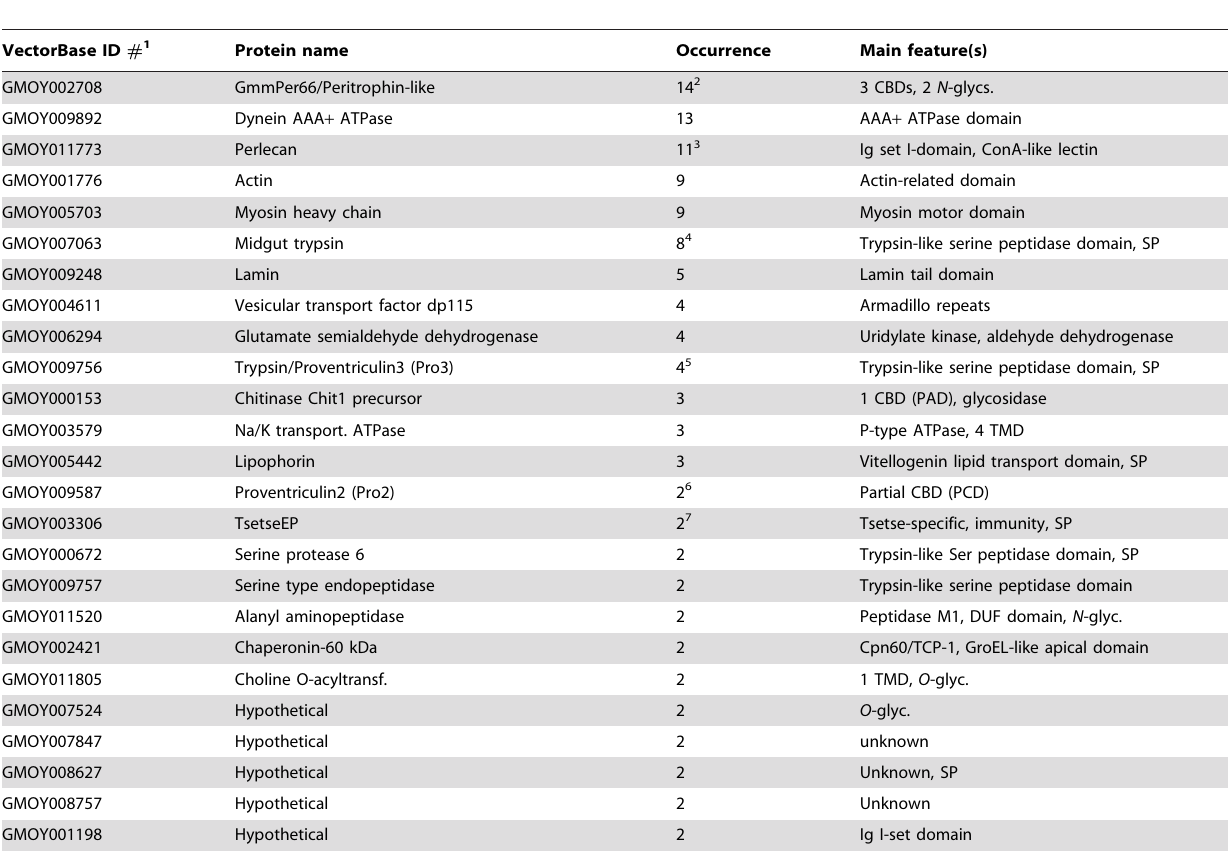
Table 1. List of the most abundant proteins detected by mass spectrometry from in-gel analyses of the peritrophic matrix of teneral G. m. morsitans